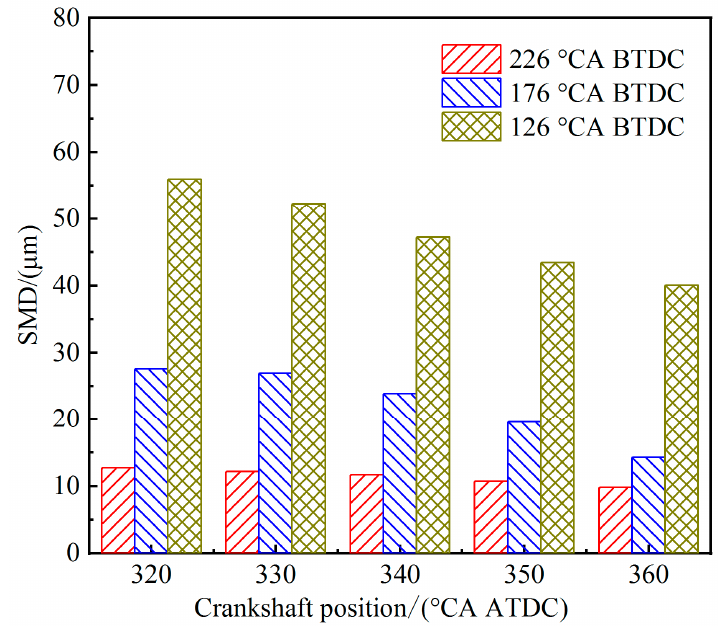
Figure 9. Atomization size of fuel droplets in-cylinder at different injection timings.